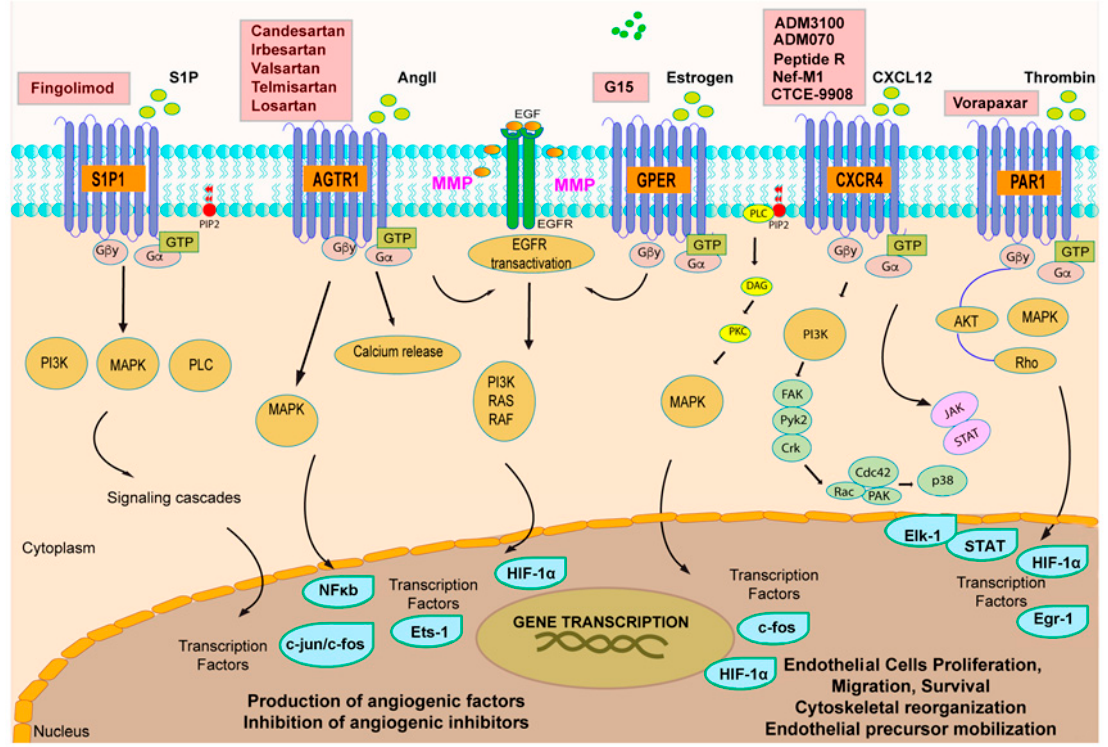
Figure 3. Schematic representation of the most relevant GPCRs, ligands, downstream pathways and candidate drugs involved in the regulation of the angiogenic process. S1P1, sphingosine 1 phosphate receptor 1; AGTR1, angiotensin II receptor type 1; GPER, G protein-estrogen receptor; EGFR, epidermal growth factor receptor; CXCR4, C-X-C chemokine receptor type 4; PAR1, protease activated receptor 1; S1P, sphingosine 1 phosphate; AngII, angiotensin II; EGFR, epidermal growth factor; CXCL12, C-X-C motif chemokine 12; GTP, guanosine triphosphate; PI3K, phosphoinositide 3-kinase; MAPK, mitogen-activated protein kinase; HIF-1 α , hypoxia inducible factor-1 α ; STAT, signal transducer and activator of transcription; FAK, focal adhesion kinase; EGR-1, early growth response protein 1; PIP2, phosphatidylinositol 4,5-bisphosphate; PLC, phospholipase C; DAG, diacylglycerol; MMP, matrix metalloproteinase; CDC42, cell division cycle 42; PAK, p21 activated kinase; RAC, ras-related c3 botulinum toxin substrate 1.